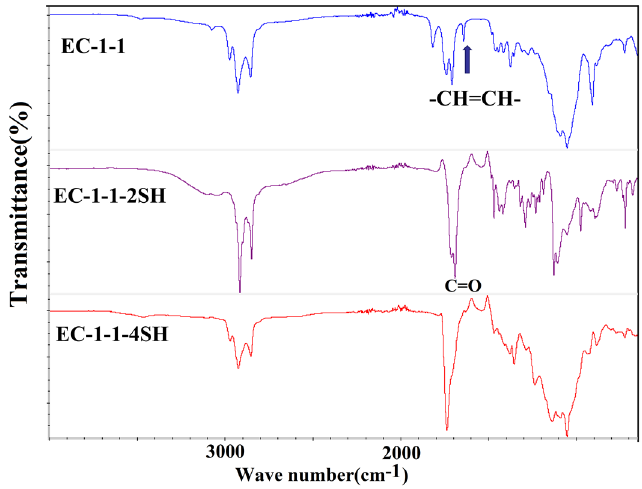
Figure 7. FT − IR of EC cross − linked polymers compared with that of EC − 1 − 1.